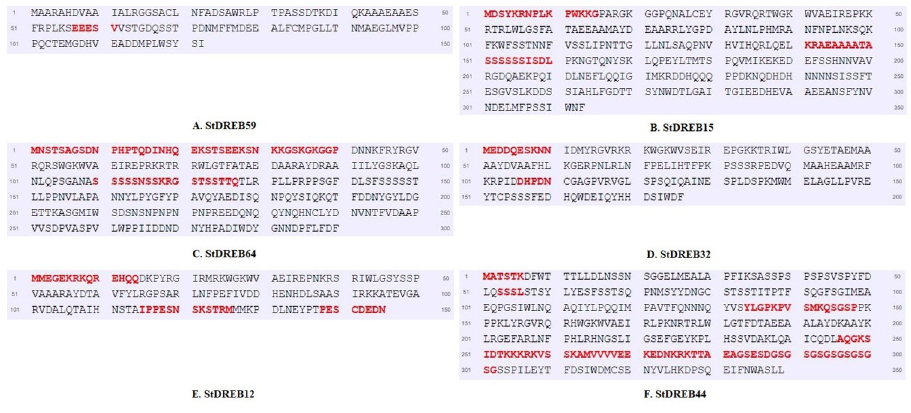
Fig 10. Predicted disordered regions (DRs) of StDREB proteins using the PrDOS server. The red residues represented the disordered regions in the amino acid sequences.